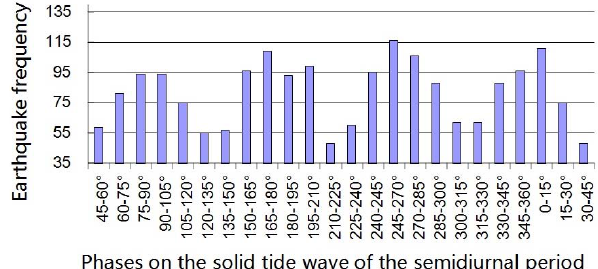
Fig. 4. M s ≥ 7 earthquake distribution relative to the phases of the semi-diurnal